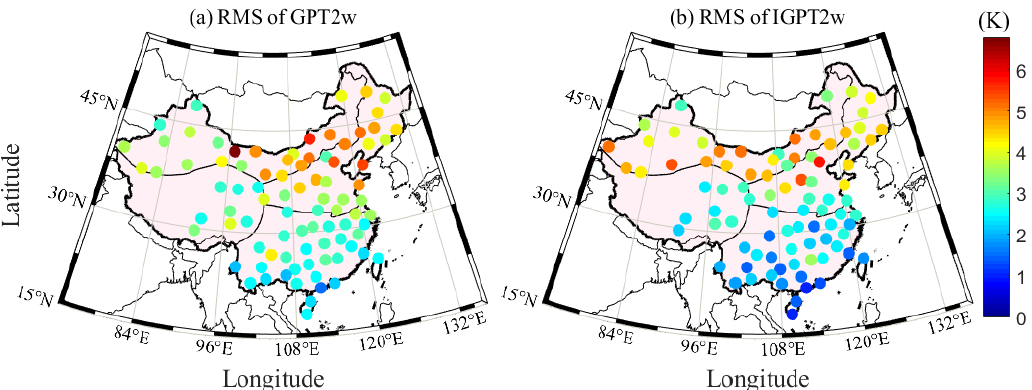
Figure 5. RMS distributions of T m differences derived from GPT2w and IGPT2w at 87 radiosonde stations when the RS-derived T m is considered as the reference.